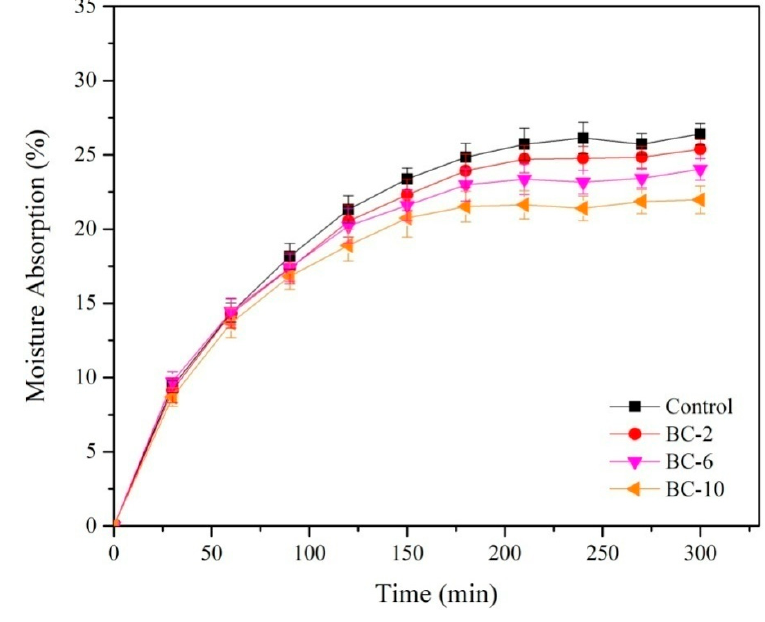
Figure 5. Moisture absorption for control and biocomposite films for 5 h testing time.